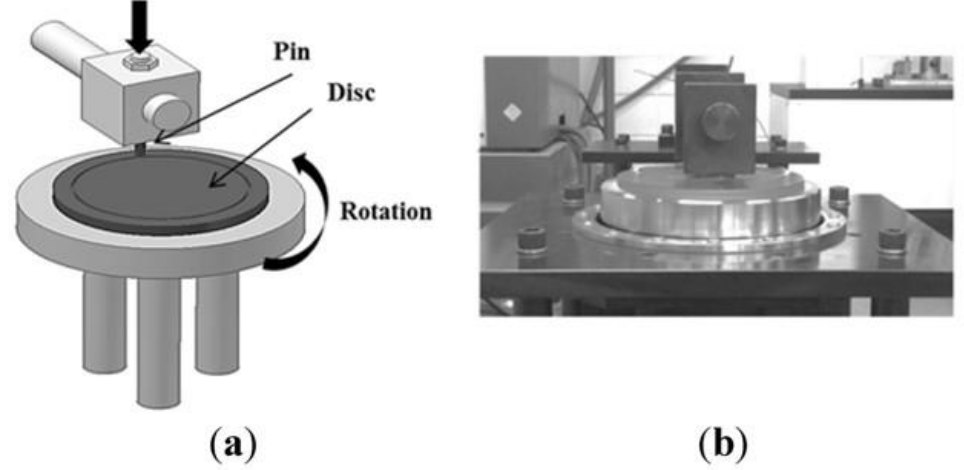
Figure 1. ( a ) The schematic of the pin-on-disc machine and ( b ) pin-on-disc used in the wear rate and measuring COF [72].